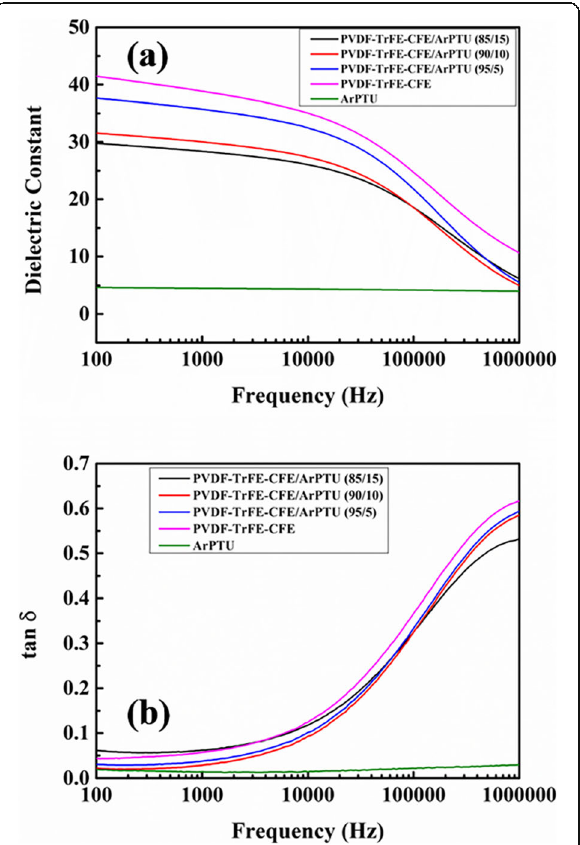
Fig. 6 a Dielectric constant of ArPTU, PVDF-TrFE-CFE, and PVDF-